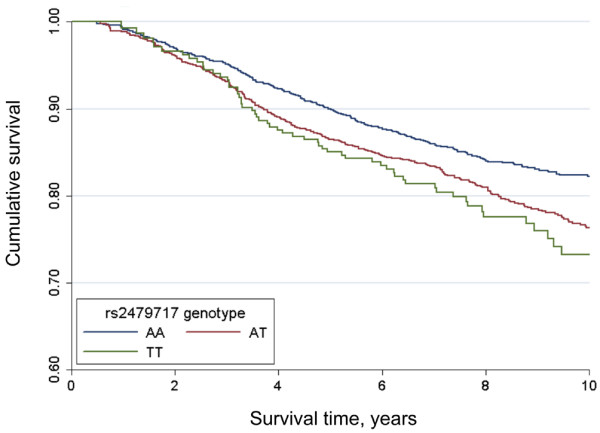
Kaplan-Meier survival function by CCND3 rs2479717 genotype. Kaplan-Meier survival probabilities for women diagnosed with invasive breast cancer in the SEARCH (Studies of Epidemiology and Risk factors in Cancer Heredity) breast cancer study by rs2479717 genotype are shown.